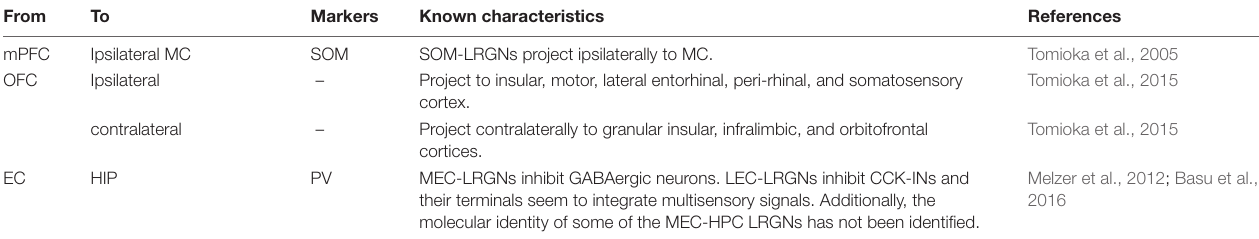
Summary table of hippocampal, cortifugal, and cortico-cortical LRGNs showing their region of origin (from), target regions (to), molecular identity, if known (markers), important characteristics such as their cellular targets (known characteristics) and the references of the corresponding works (primarily carried out in mice and to a